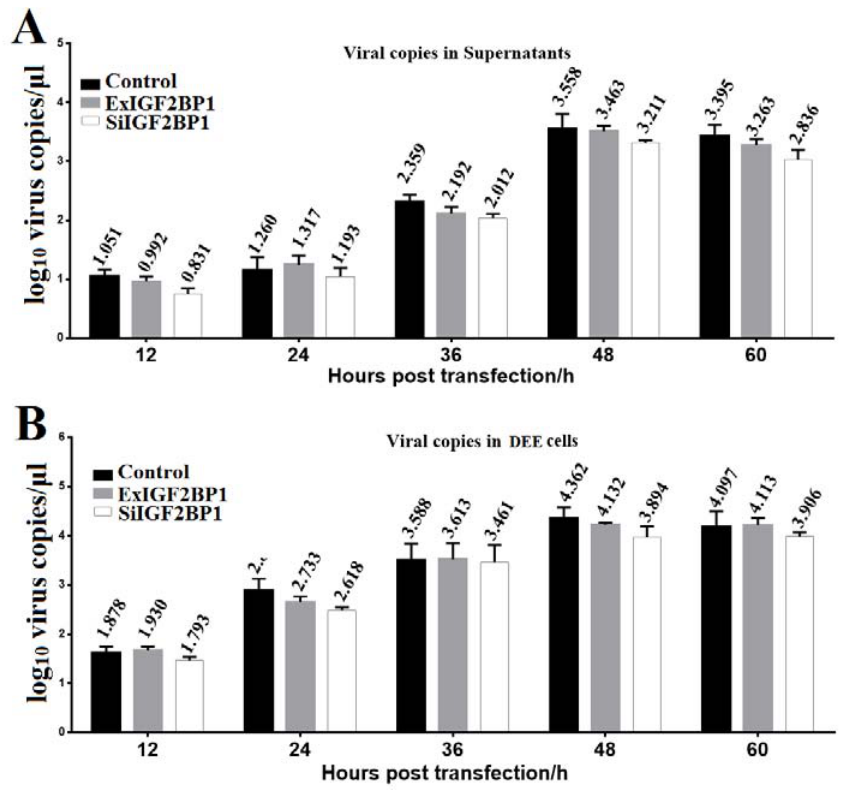
Figure 5. IGF2BP1 had no impact on viral replication. Equal amounts of the in vitro transcribed RNA of RNA ‐ launched infectious clone pR ‐ DHAV ‐ 1 were transfected into ExIGF2BP1 DEE, SiIGF2BP1 DEE, and normal DEE cells. Total RNA was extracted from the supernatant ( A ) and DEE cells ( B ), and the extracted RNA was immediately used for RT ‐ qPCR measurement. Bars represent the mean ± standard deviation of three replicate experiments for each group.